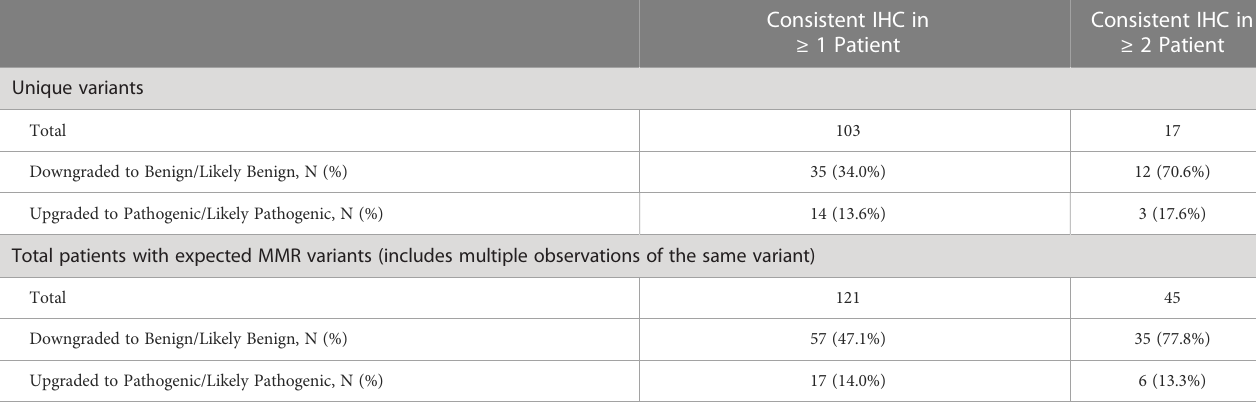
Consistent IHC in ≥ 2